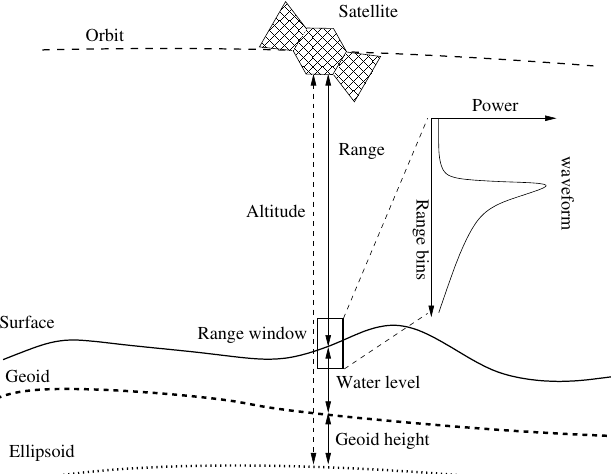
Figure 1. The principle of satellite altimetry.